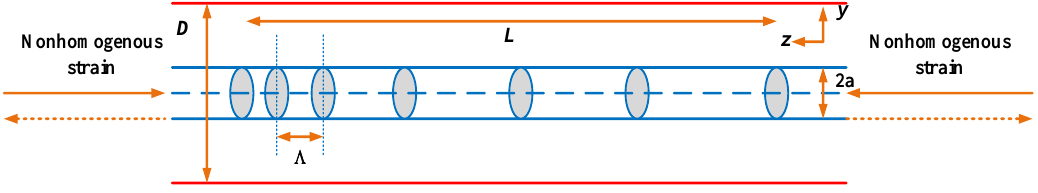
Figure 15. Axial nonuniform stress structure diagram of the FBG.